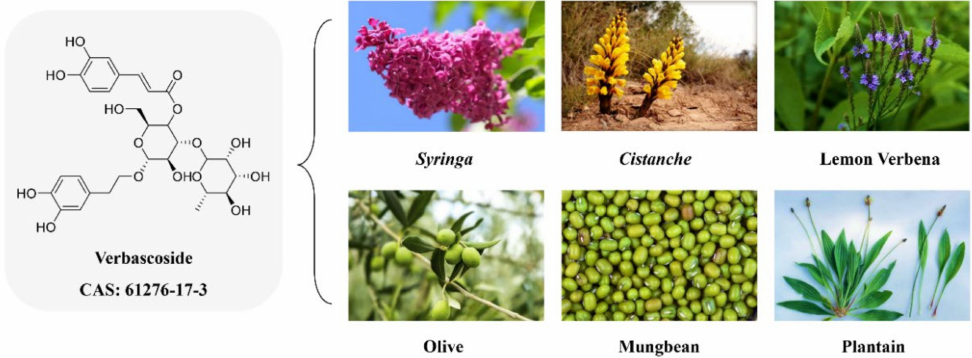
Figure 1. Chemical structure and natural sources of